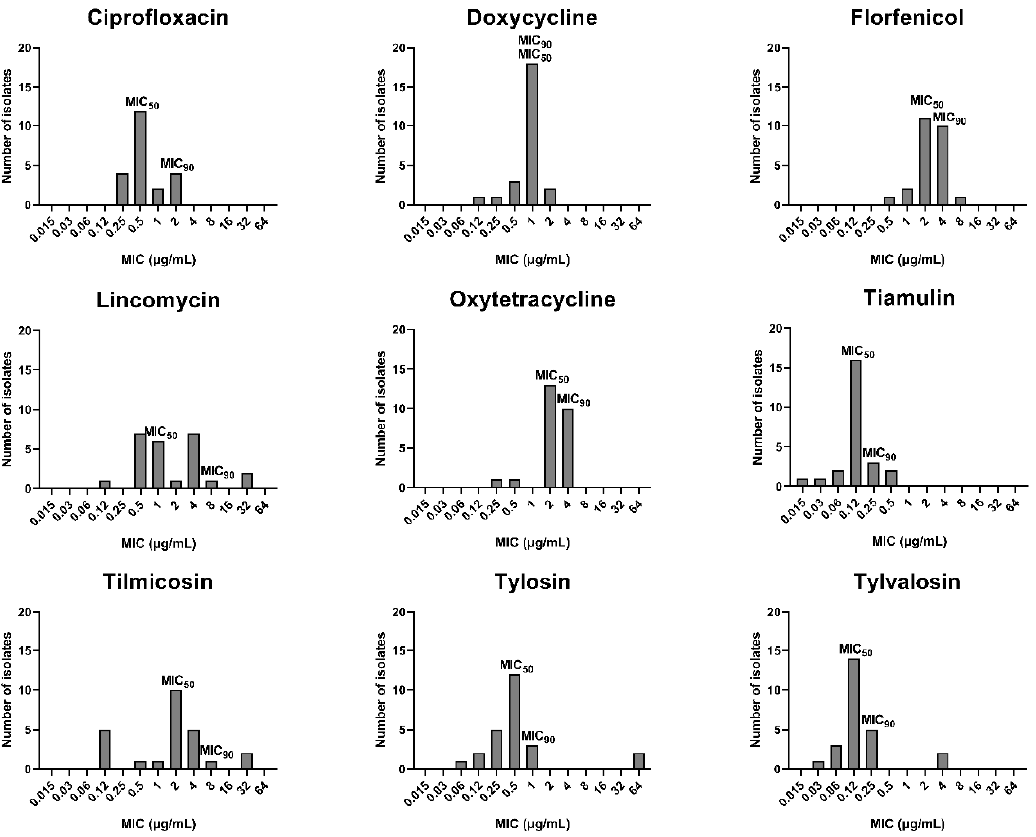
Figure 1. The MIC distributions of 25 strains of M. hyorhinis field isolates. MIC 50 for the lowest concentrations that inhibit 50% of bacterial isolates. MIC 90 for the lowest concentrations that inhibit 90% of bacterial isolates. Table 1. The background information and MIC data of the seven ciprofloxacin-sensitive M. hyorhinis isolates used for in vitro